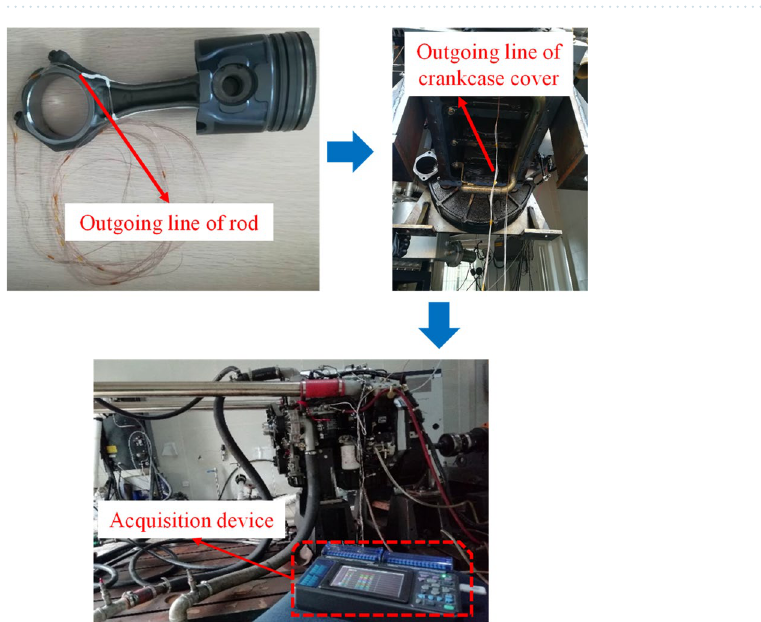
Figure 1. Sketch map of piston measuring points of ( a ) cutaway view and ( b ) physical view.